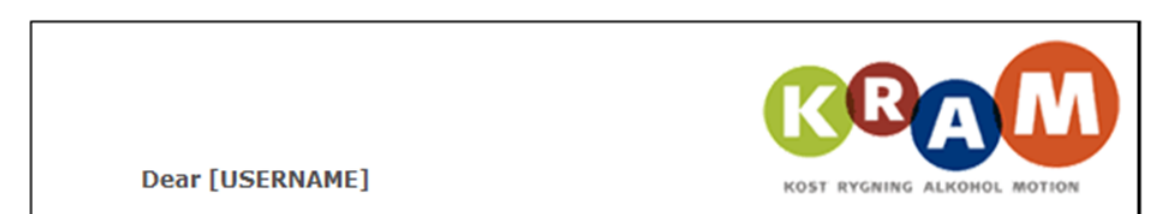
Figure 3. Screenshot of the control group